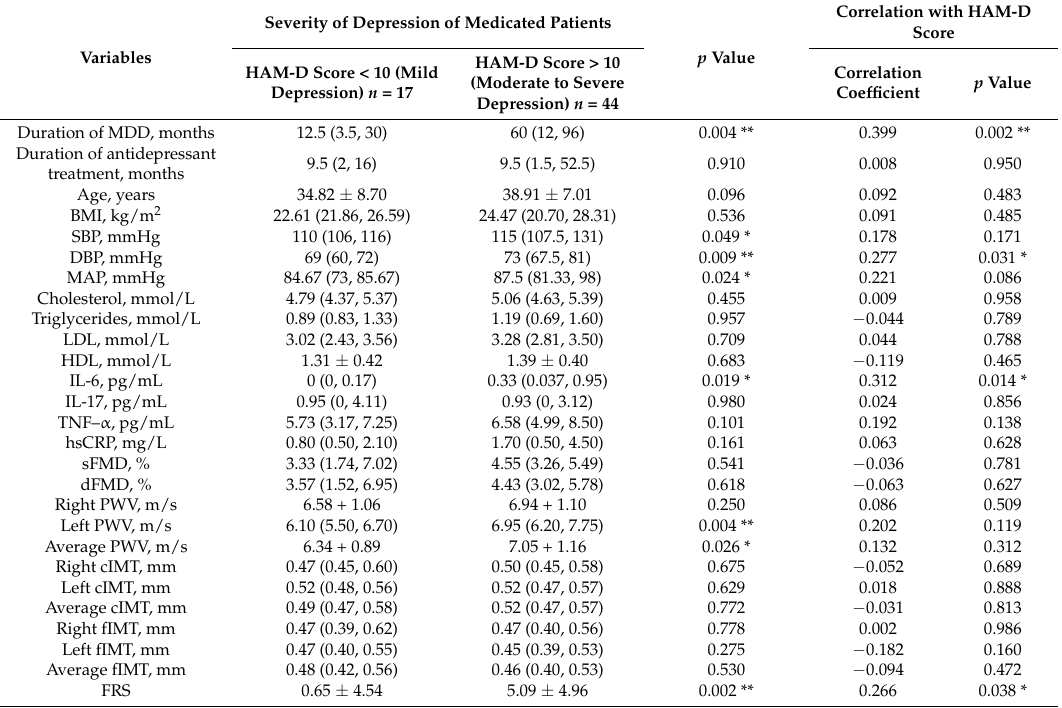
Table 2. Characteristics of medicated patients who remained as non-depressed/mildly depressed versus those who remained moderately to severely depressed and correlation between clinical factors and Hamilton Depression Rating Scale (HAM-D)